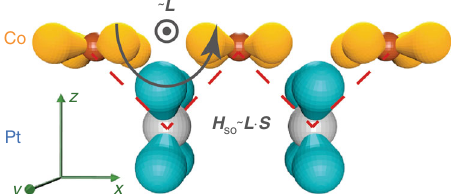
Fig. 6 Schematic illustration of the spin canting. Explicit illustration of the onset of the orbital angular momentum and how SOC induces spin canting from it. The red and grey spheres represent the top ferromagnetic and bottom normal metal atoms in each layer, while the yellow and blue spheres represent the d xy (top) and d yz (bottom) orbitals, respectively. Dotted red lines and black curved arrow indicate the electron hopping path and effective electron orbiting motion due to the hopping,